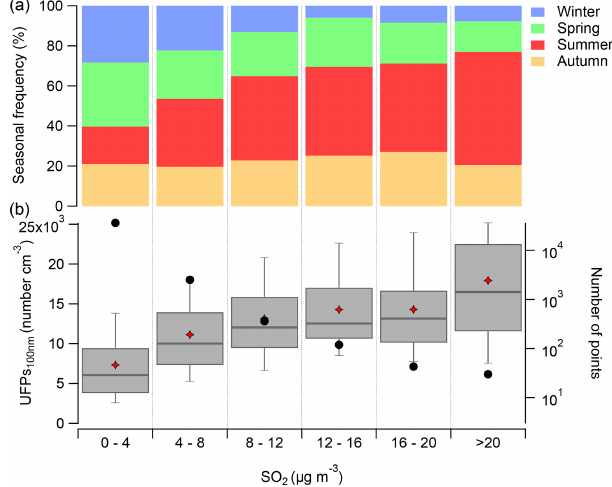
Figure 5. Box plots of UFP < 100nm number for different SO 2 con- centration bins (b) and seasonal occurrence frequency for each bin (a) . The red diamonds are the mean, the bands inside the box are the median, the bottom and top of the box represent the lower and upper quartiles, respectively, and the ends of the whiskers show the 10th and 90th percentiles. The black circles denote the number of data points (15min resolution) encountered in each